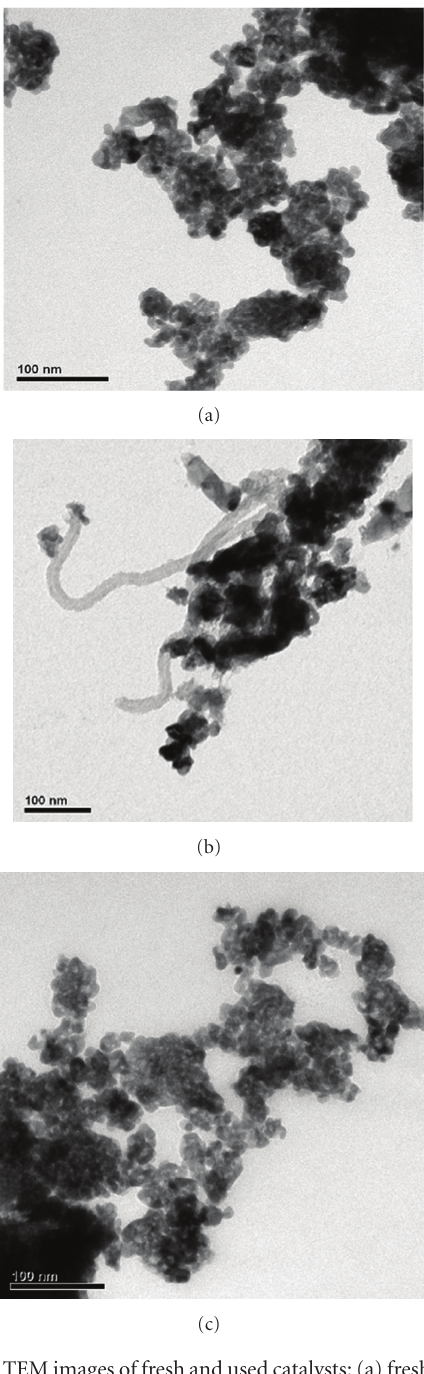
Figure 3: TEM images of fresh and used catalysts: (a) fresh, (b) after OSRE reaction, and (c) after SRE reaction.